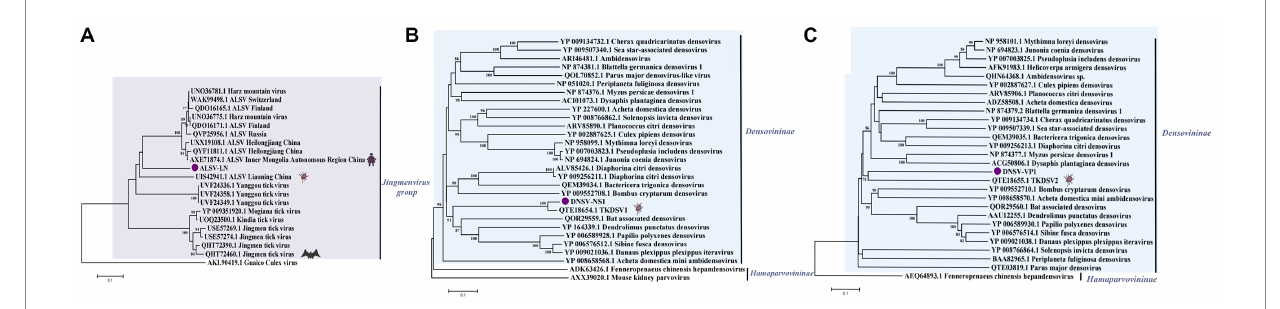
FIGURE 4 (A) Phylogenetic trees of ALSV-LN based on VP1a (121 aa) of members within Jingmenvirus group. (B) Phylogenetic trees of DNSV-NS1 (297 aa) based on NS1 of members within Densovirinae. (C) Phylogenetic trees of DNSV-VP1 (225 aa) based on VP1 of members within Densovirinae. Nodes with